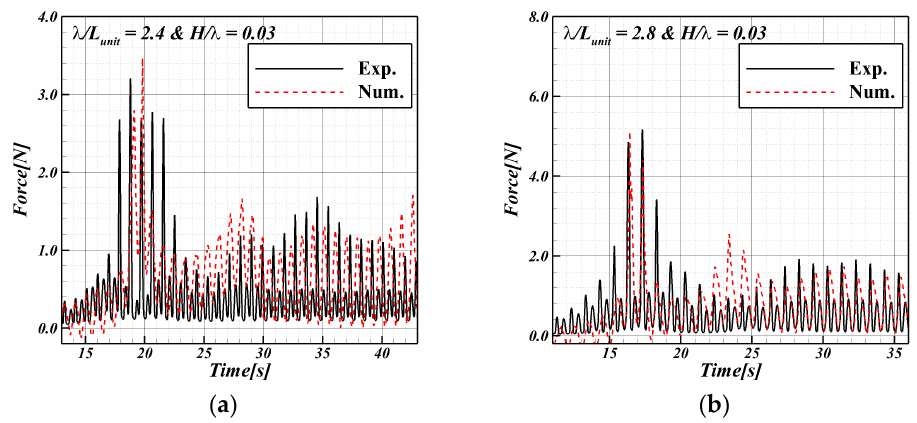
unit = 2.4; ( b ) λ / L unit = 2.8.